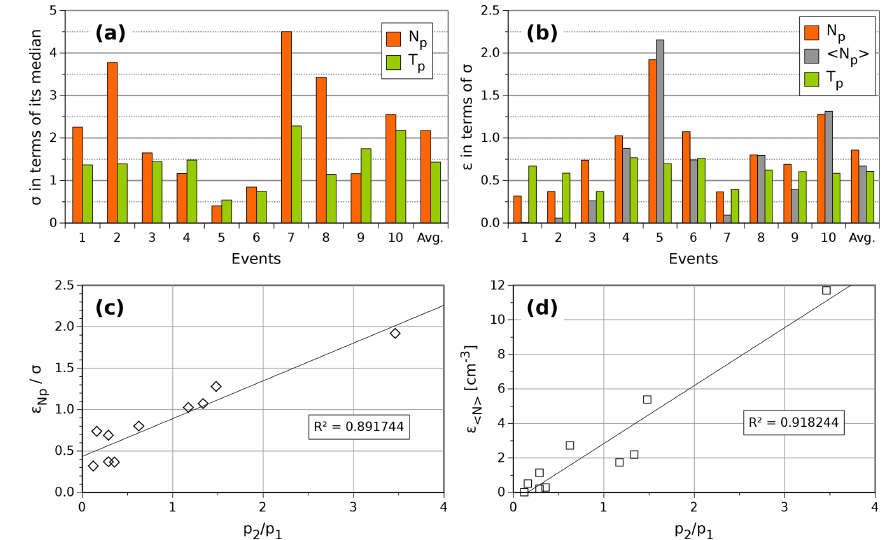
Figure 8. Histograms of the standard deviations and errors associated with the density (orange) and temperature (green) of protons, and dispersion of density errors as functions of the solar wind ram pressure quotient. (a) Standard deviation ( σ ) in terms of the associated median value ( < N p > ), both calculated for in situ data during (cid:49)T . (b) Average errors ( (cid:15) ) associated with our synthetic profiles in terms of their corresponding standard deviations. The rightmost bars in (a) and (b) show the average values of (cid:15) and σ , respectively. (c) Density errors (open diamonds) in terms of their corresponding standard deviations vs. ahead and behind the ram pressure quotient. (d) Mean density errors (open squares) vs. ahead and behind the ram pressure quotient. Solid black lines in (c) and (d) are the corresponding regression tendencies. We also overplot the associated squared correlation